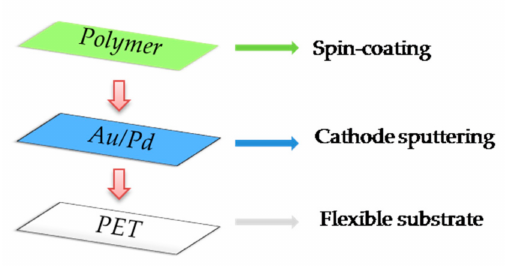
Figure 2. Schematic structure of the deposition of the individual elements of the PET/polymer